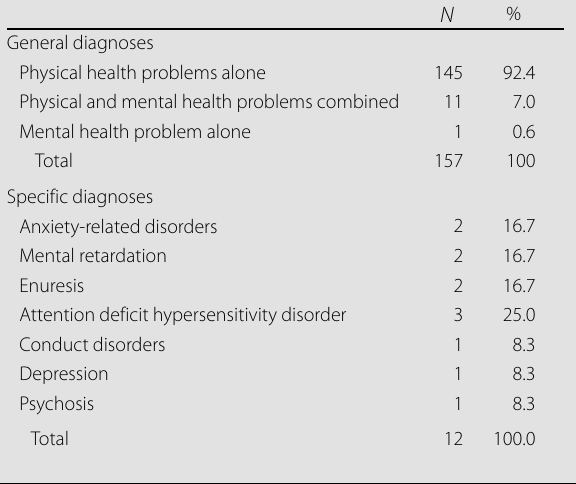
Table II. Categorisation of routine diagnoses made by PCPs